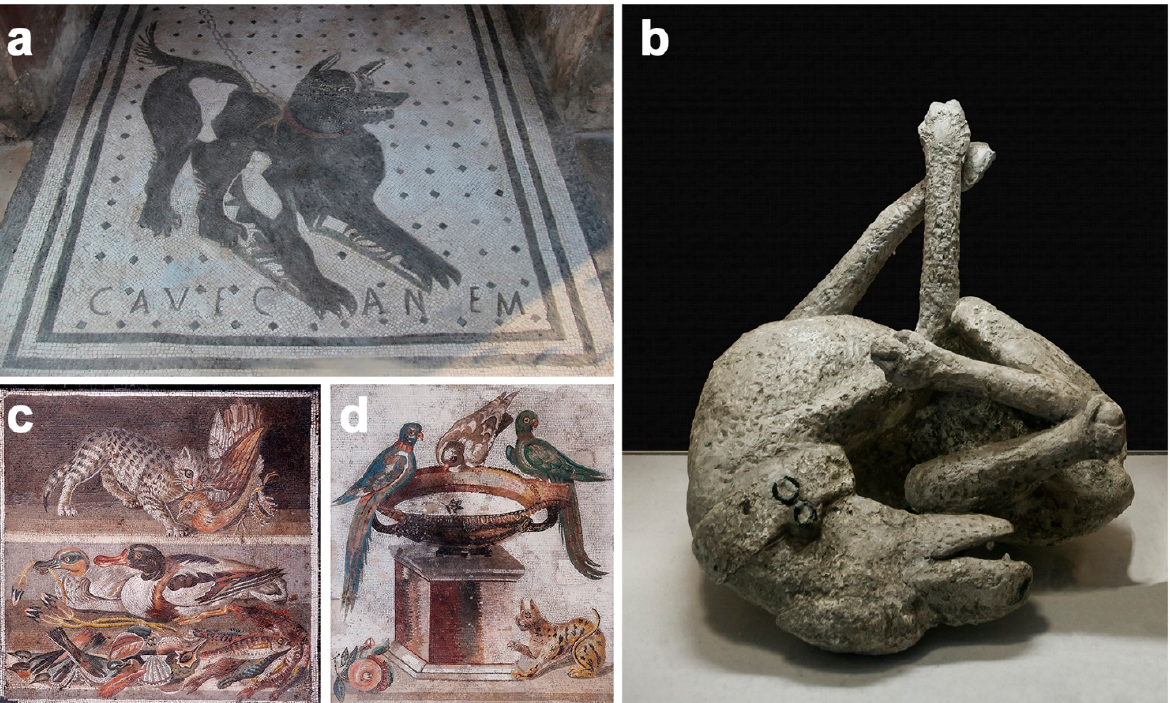
Figure 4. ( a ) Mosaic at the entrance door to the House of the Tragic Poet ( Pompeii ) depicting a dog served as a warning to intruders, with the inscription ‘ Cave canem ’ (Beware of the dog!) [Author: Sailko. Distributed under a CC BY-SA 4.0 license. Available online: https://cutt.ly/JRCZnid. Accessed: 30 October 2021]. ( b ) Plaster cast of a watchdog found in the House of Vesonius Primus ( Pompeii ), showing his leather collar with the two bronze rings for the chain [Author: Jebulon. Distributed under a CC0 1.0 license. Available online: https://cutt.ly/TRCZmFG. Accessed: 30 January 2021]. ( c ) Mosaic from the House of the Faun ( Pompeii ) representing a cat attacking a partridge